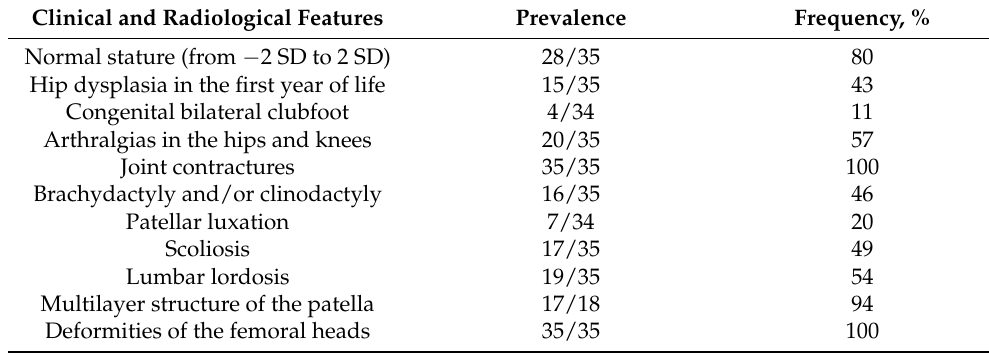
Table 4. Prevalence and frequency of clinical and radiological features in patients with MED type 4. Clinical and Radiological Features Prevalence Normal stature (from − 2 SD to 2